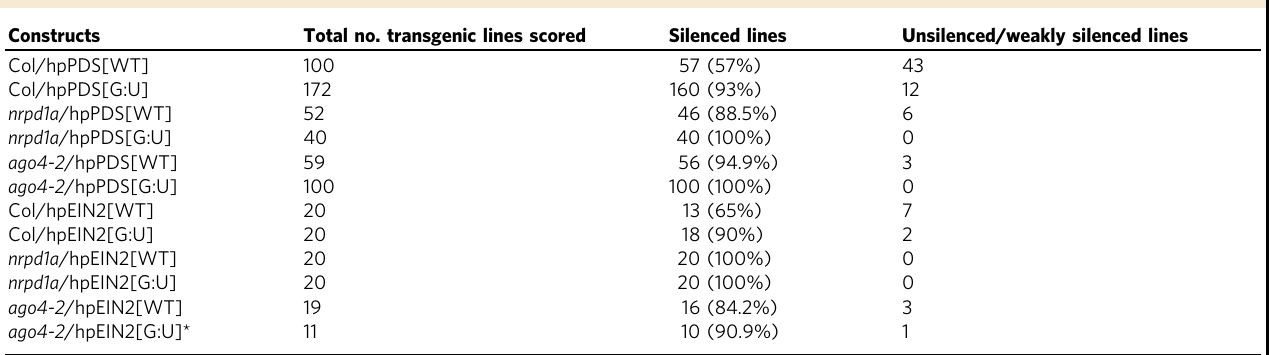
Table 2 Summary of PDS and EIN2 RNAi in RdDM mutant backgrounds.